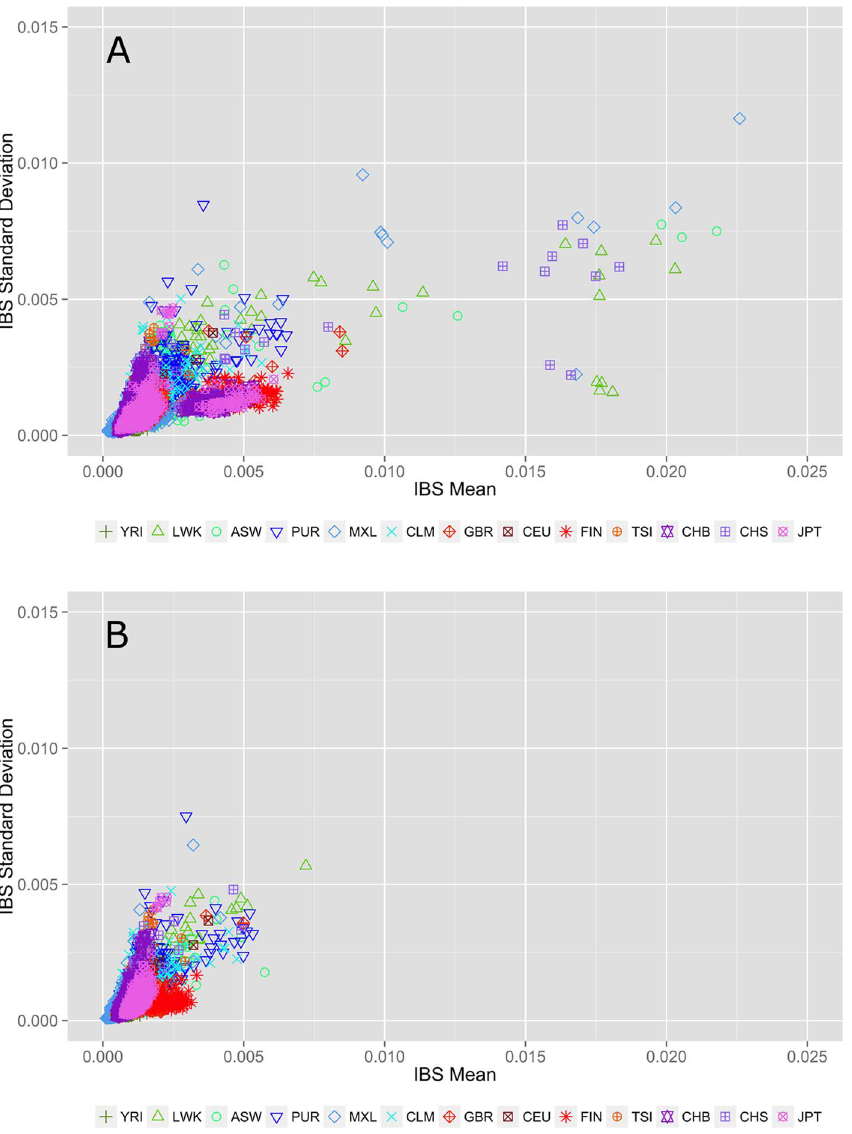
Figure 2. Within population identity-by-state (IBS) estimations A) before and B) after removing individuals with cryptic relatedness. The x-axis represents the IBS mean for low frequency variants averaged over 22 autosomal chromosomes. The y-axis corresponds to the standard deviation of IBS scores across 22 autosomal chromosomes. The colors and point types correspond to each population; color schemes correspond to general ancestry groups as defined for Figure 1. Each point represents a population pairwise IBS calculation (i.e. YRI-YRI, not YRI-CEU). Identifying and excluding related individuals removes the outliers seen in the top plot.